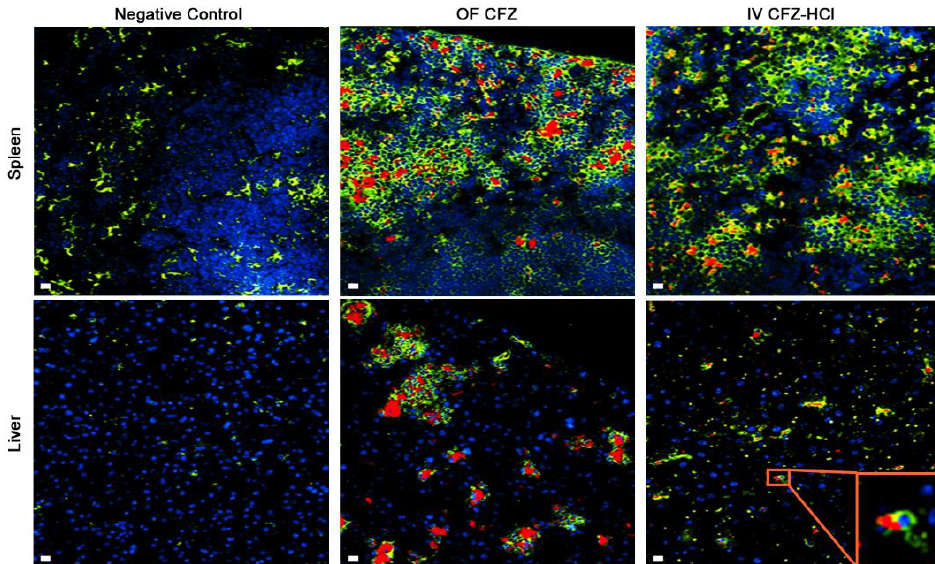
Figure 6. In vivo stability and phagocytosis of the biomimetic formulation of micronized CFZ-HCl salt crystals following IV injection to mice compared to 9 weeks orally fed (OF) CFZ mice. Images represent CD68 immunohistochemistry of cryo-sections of spleen and liver from OF CFZ and untreated (negative control) mice. Blue (DAPI)—nucleus; green (FITC)—CD68(+) macrophages; red (Cy5)—CLDIs/CFZ-HCl microcrystals. Scale bar = 20 µm.